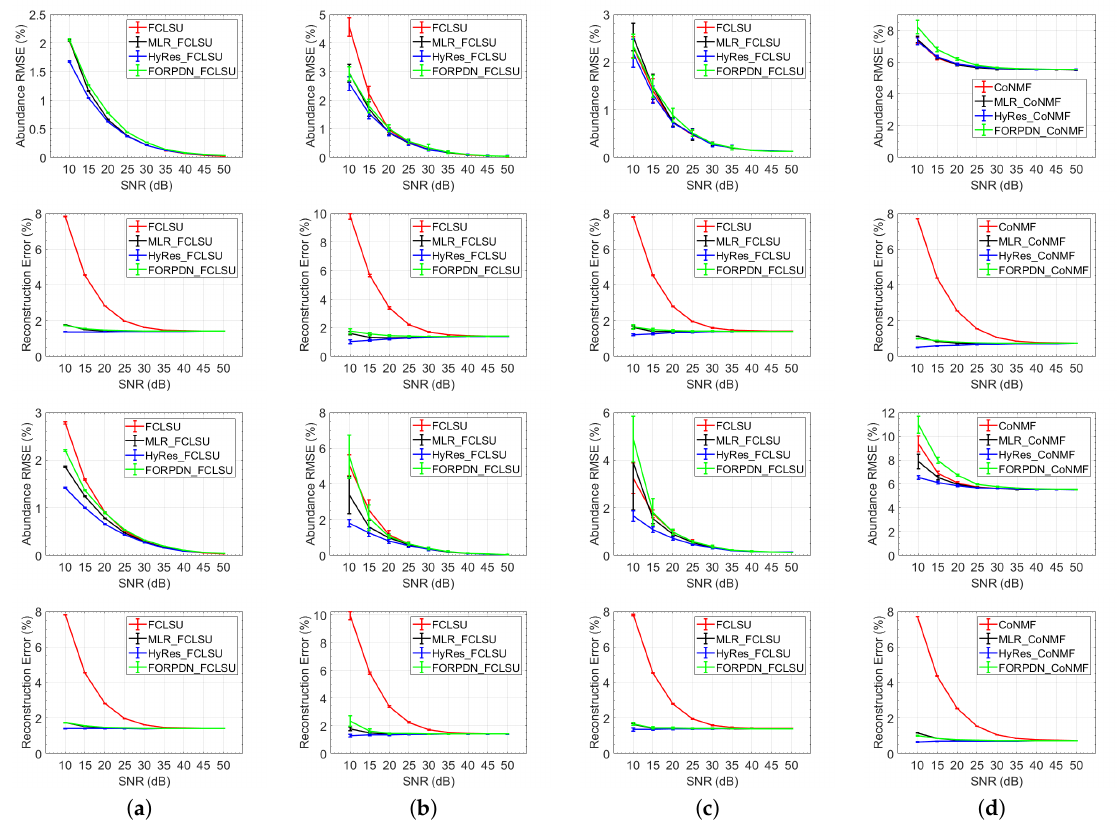
Figure 7. Real data (top two rows η = ∞ and bottom two rows η = 18): The spectral unmixing results on the Samson image in terms of abundance RMSE and reconstruction error. ( a ) Ground truth endmembers; ( b ) extracted endmembers; ( c ) library endmembers; ( d ) estimated